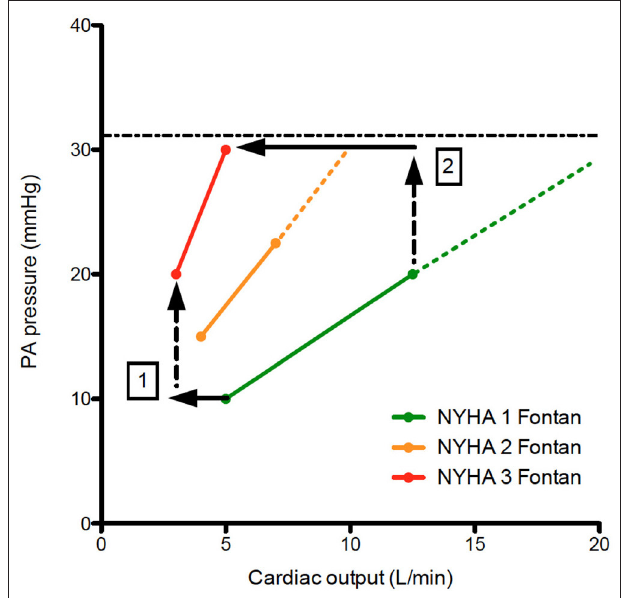
FIGURE 3 | Pressure flow plots indicating the increase in PA pressure vs. cardiac output during exercise. When comparing NYHA 1 Fontan patients with NYHA 2&3 Fontan patients, note there is a decrease in cardiac output despite increase in resting PA pressure (1). During exercise, the increase in PA pressure is steeper for NYHA 2&3 patients. A hypothetical maximum of PA pressure (systematic venous pressure) results is an exacerbated decrease in cardiac output resulting in significant functional limitation of the Fontan patient (2). The dashed lines represent hemodynamic reserve of the Fontan